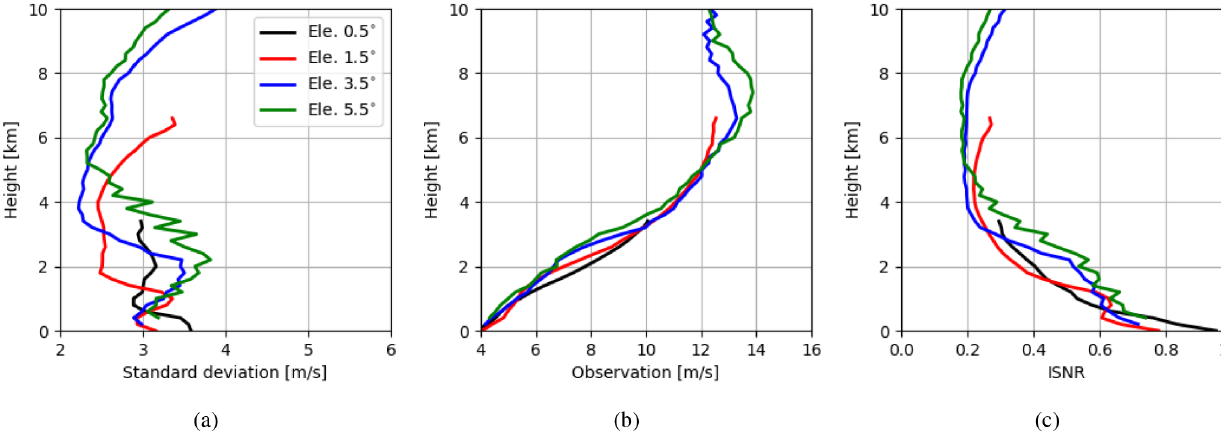
Figure 11. The same as Fig. 9 but for radial wind